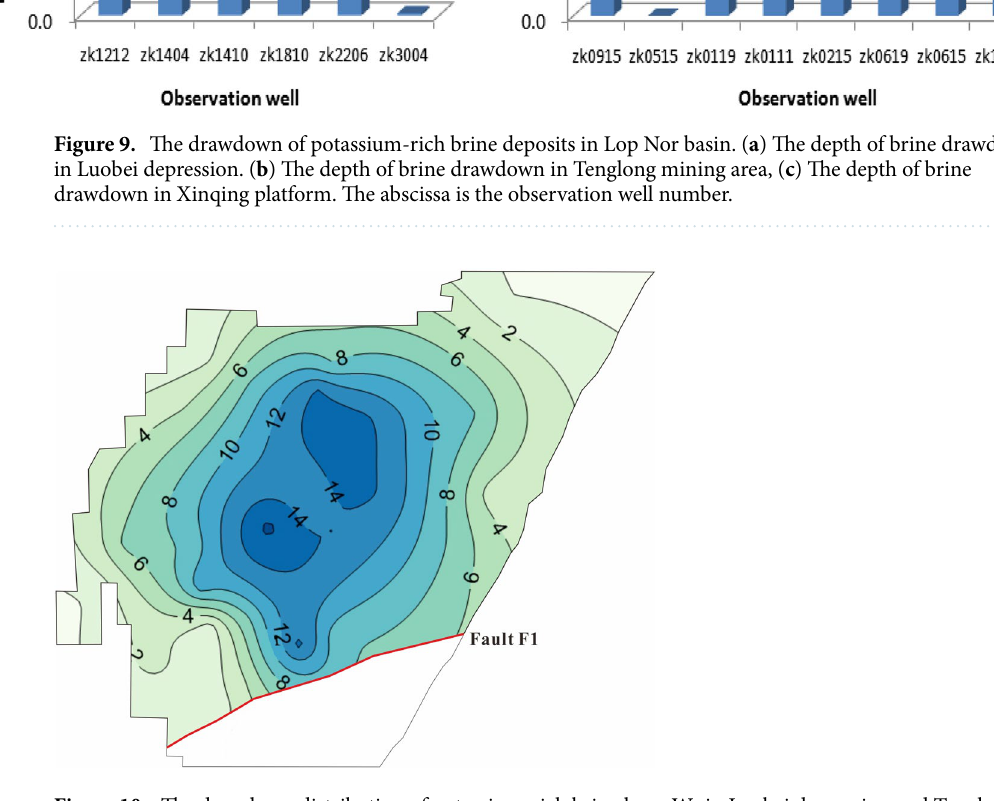
Figure 10. The drawdown distribution of potassium-rich brine layer W 1 in Luobei depression and Tenglong mining area. The unit of brine drawdown is meter. The red line indicates the